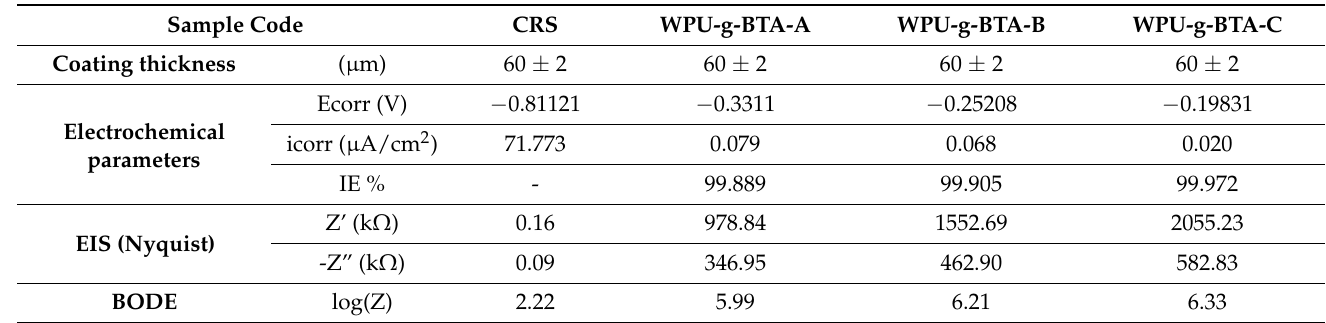
Table 2. Electrochemical parameters, the corresponding inhibition efficiency (IE %), EIS, and BODE results for raw CRS and CRS electrode coated with WPU-g-BTA-A, WPU-g-BTA-B, and WPU-g-BTA-C in 3.5 wt% NaCl (aq) at 298